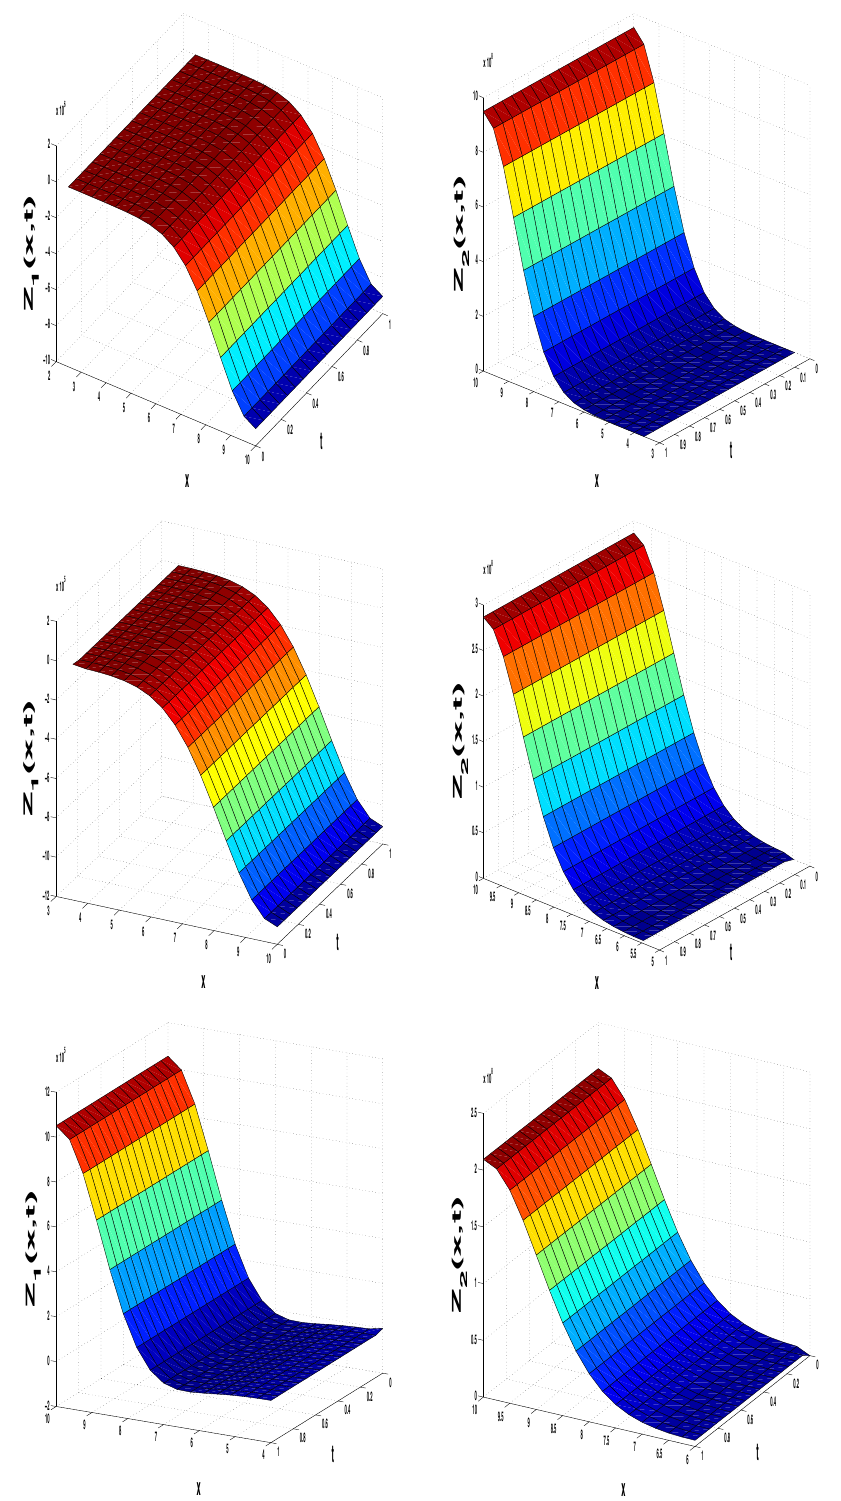
Fig. 3 Numerical solutions of Z 1 ( x , t ) and Z 2 ( x , t ) for example 2 when a α 1 = 0 . 25 ,β 1 = 0 . 50, b α 1 = 0 . 75 ,β 1 = 0 . 75, and c α 1 = 1 . 00 ,β 1 = 1 . 00 at time T =